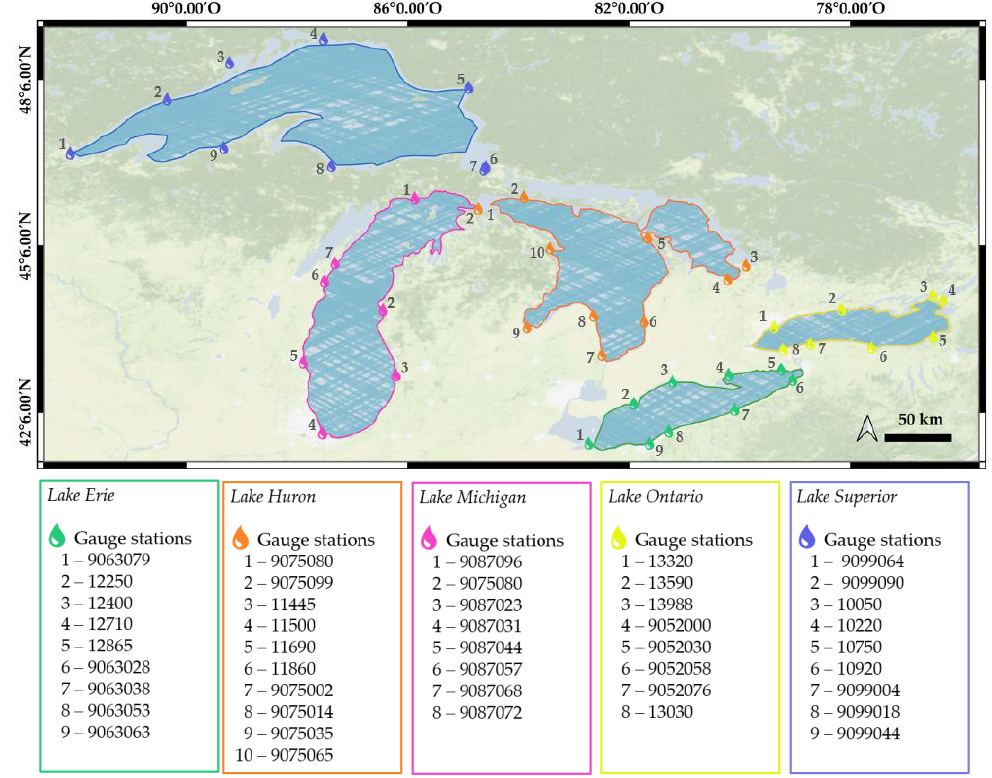
Figure 1. North American Great Lakes Region. The blue lines correspond to the GEDI acquisitions considered in this study.